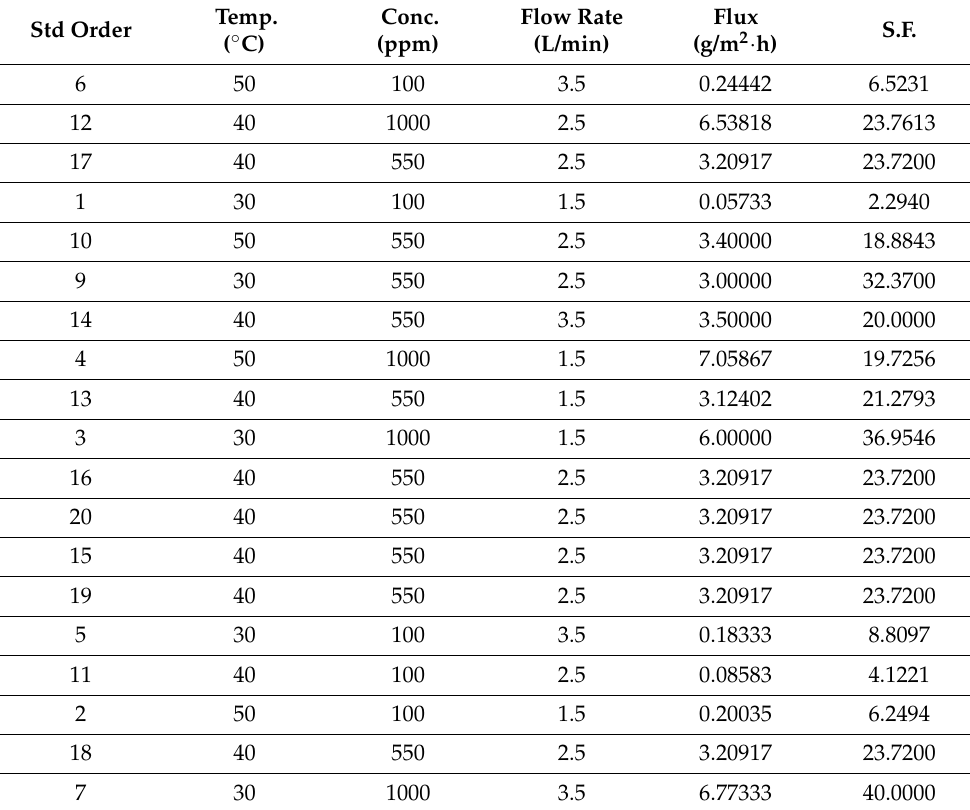
Table 3. Experimental data points and responses.